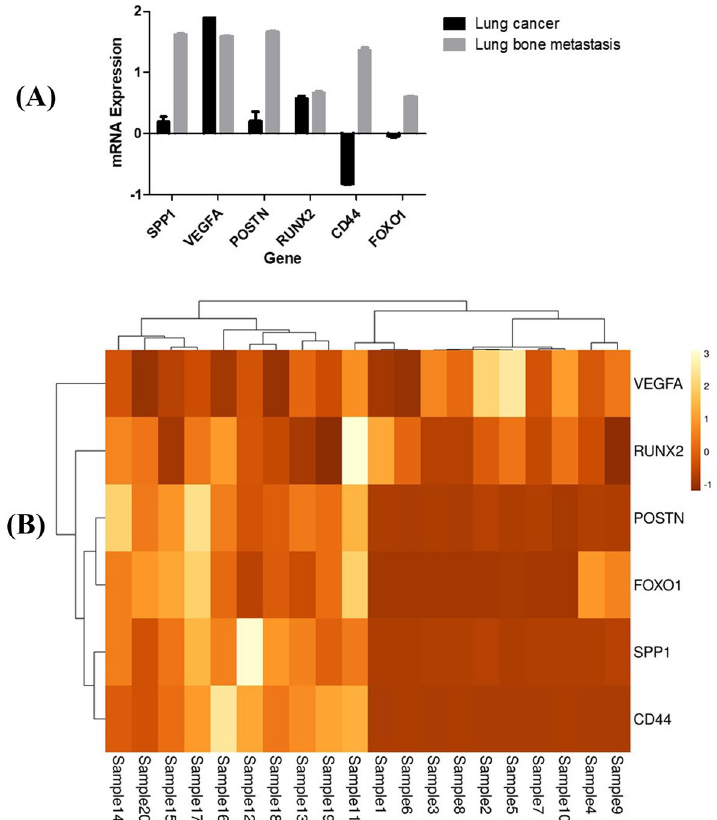
Figure 4. ( A ) Gene expression study using liquid biopsy approach. Primary lung EVs mRNA, advance stage lung cancer with bone metastases, as well normal EVs mRNA analysed with qRT-PCR. ( B ) Unsupervised hierarchical clustering of primary lung cancer with advanced stage bone metastatic samples. Clustering was based on six differentially expressed genes at a false discovery ratio level of 0.05. The colored bar specifies the variation in gene expression in target samples as compared to reference cells i.e., Brown, more expressed and cream, less expressed in target samples. Further, the black lines of the dendogram stand for the support for each clustering. The metric performed was Euclidean distance, with complete linkage for distance between clusters. 1 to 10 sample primary lung cancer and 11 to 20 samples for lung cancer bone